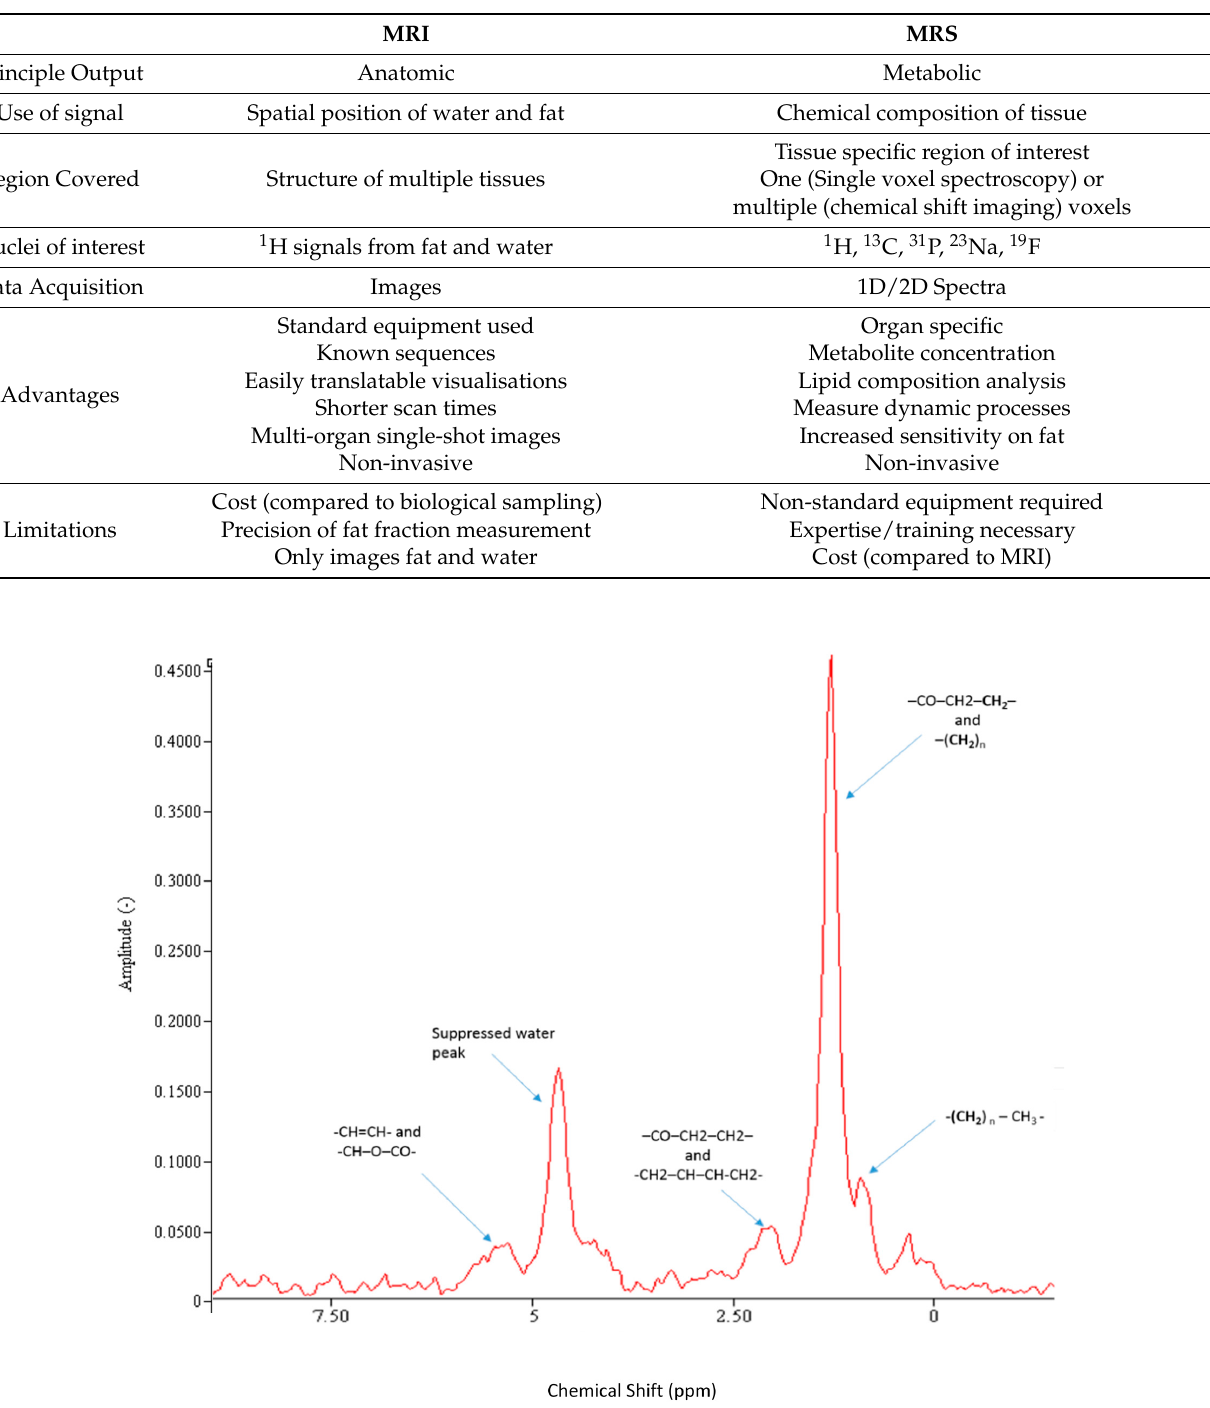
Table 1. Differences between MRI and MRS in NAFLD application.